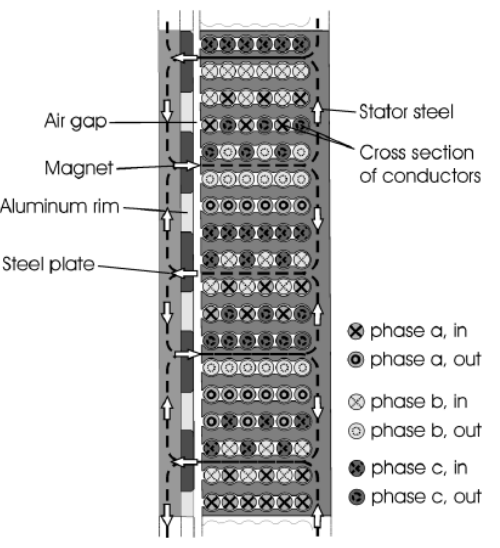
Figure 25. Magnet flux paths in a linear permanent magnet generator (LPMG). From Danielson, Detailed study of the magnetic circuit in a longitudinal flux permanent-magnet synchronous